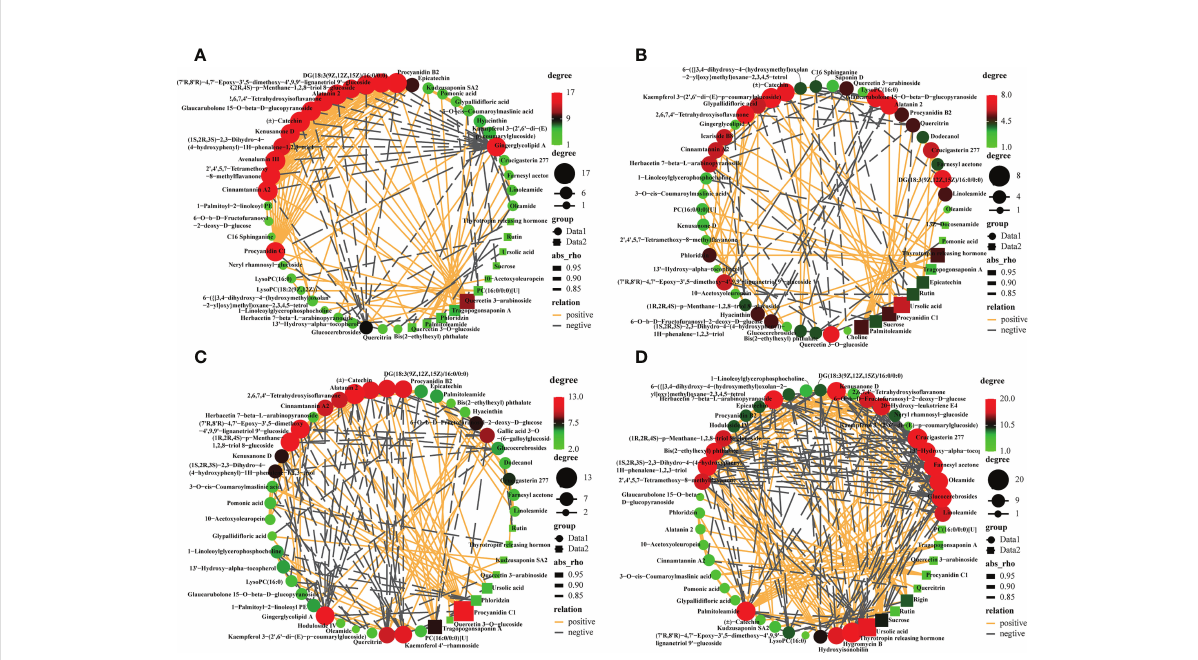
FIGURE 3 Metabolites -metabolites correlation within buds in different varieties. Positive and negative correlations are represented in orange and grey, respectively. Different color of nodes denotes distinct metabolites. (A) The interaction networks of 50 most abundant metabolites in the CL3. (B) The interaction networks of 50 most abundant metabolites in the CL4. (C) The interaction networks of 50 most abundant metabolites in the CL40. (D) The interaction networks of 50 most abundant metabolites in the CL